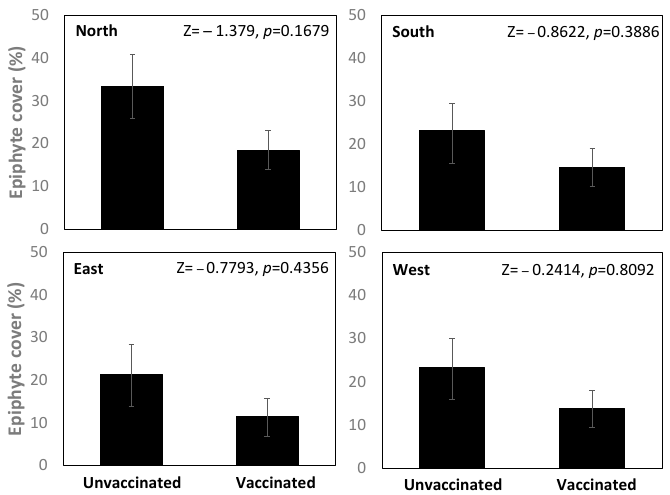
Figure 2. Epiphyte cover (%) on the trunks of unvaccinated and vaccinated elms was surveyed in the four cardinal directions (N, S, E, W). Shown are the mean values of 17 replicates and Wilcoxon two-sample test results. Vertical bars represent the standard error of the mean ( n = 17).